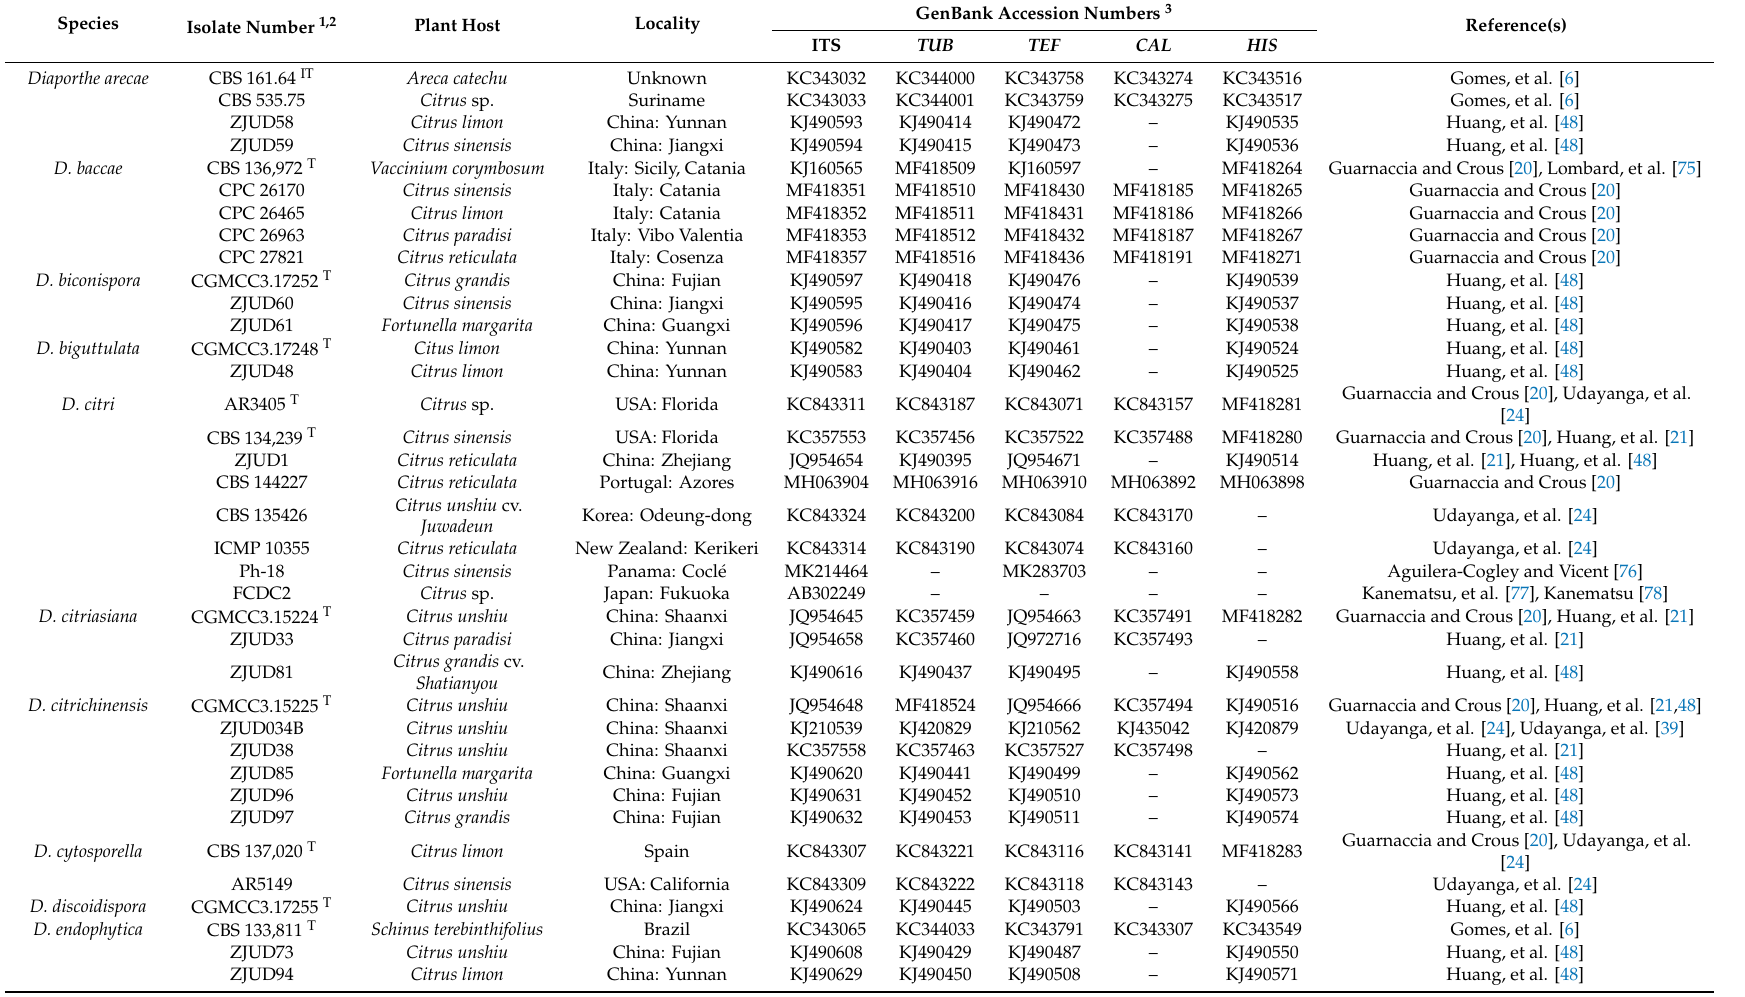
Table 4. List of Diaporthe species used for phylogenetic